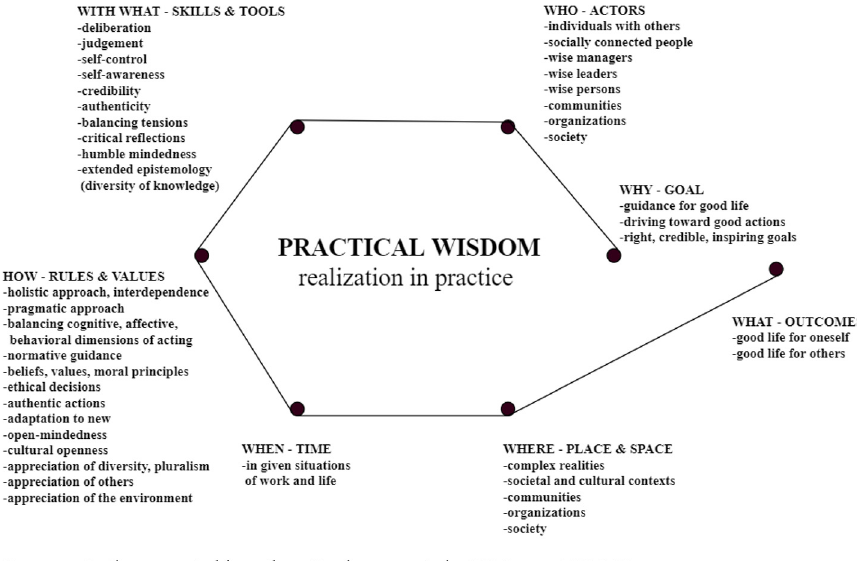
Figure 2. Realizing PW in